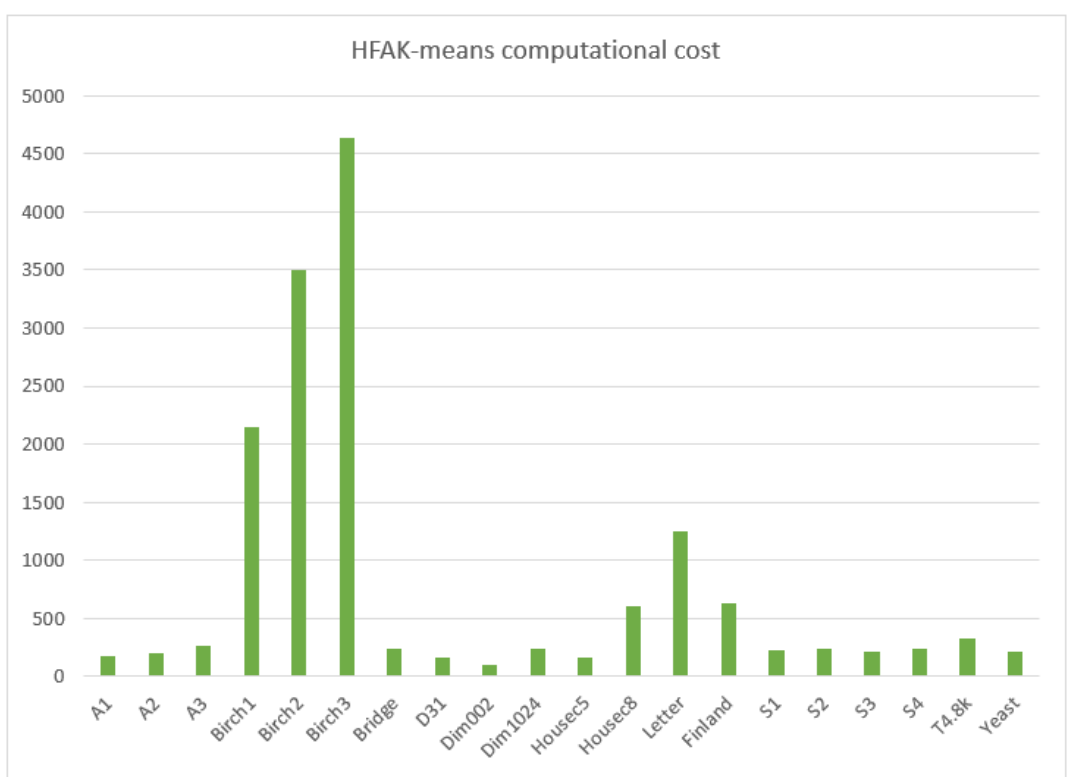
Figure 2. Mean execution run time of HFA-K-means on DBI for 20 high-dimensional datasets over 20 runs.